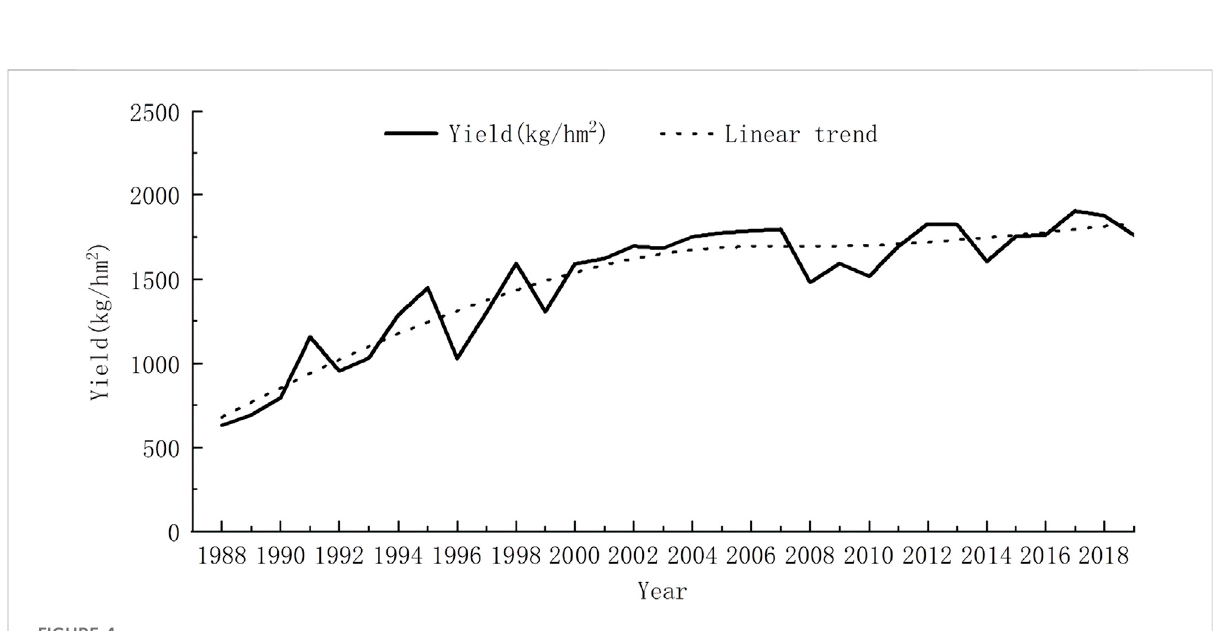
FIGURE 4 1988 – 2019 Separation diagram of actual yield and trend